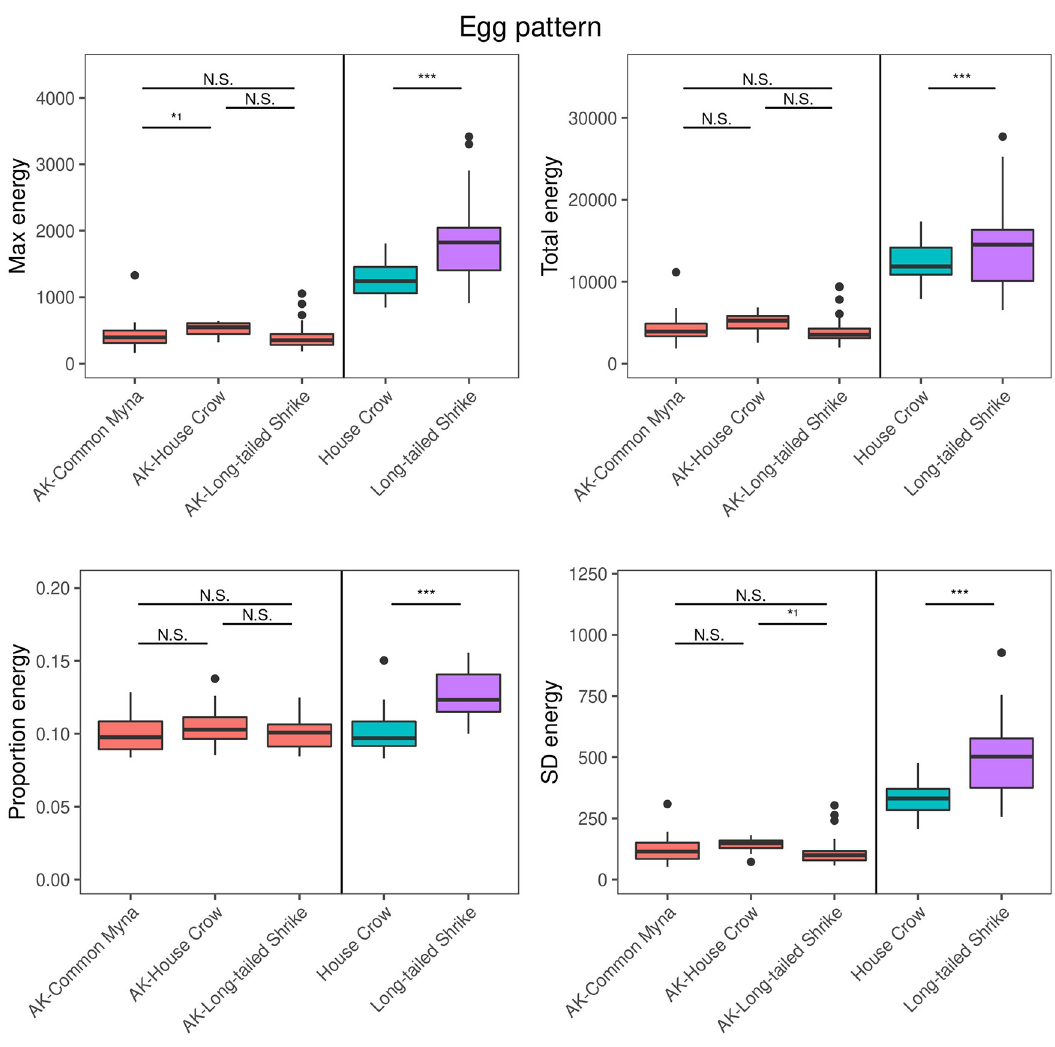
Fig 3. Egg spotting pattern variables of Asian koel (AK) eggs laid in the nests of three host species (left panel) and two host species (house crow and long-tailed shrike; right panel). Asterisks denotes significant difference between Asian koels and hosts, respectively, based on linear-mixed effects model outputs (see Table 1; N.S. p > 0.05, � p < 0.05, �� p < 0.01, ��� p < 0.001). Tests of Asian koel and hosts eggs were performed separately. Vertical bars depict the 95% confidence interval. 1 Significant only after log- transformation (see S1